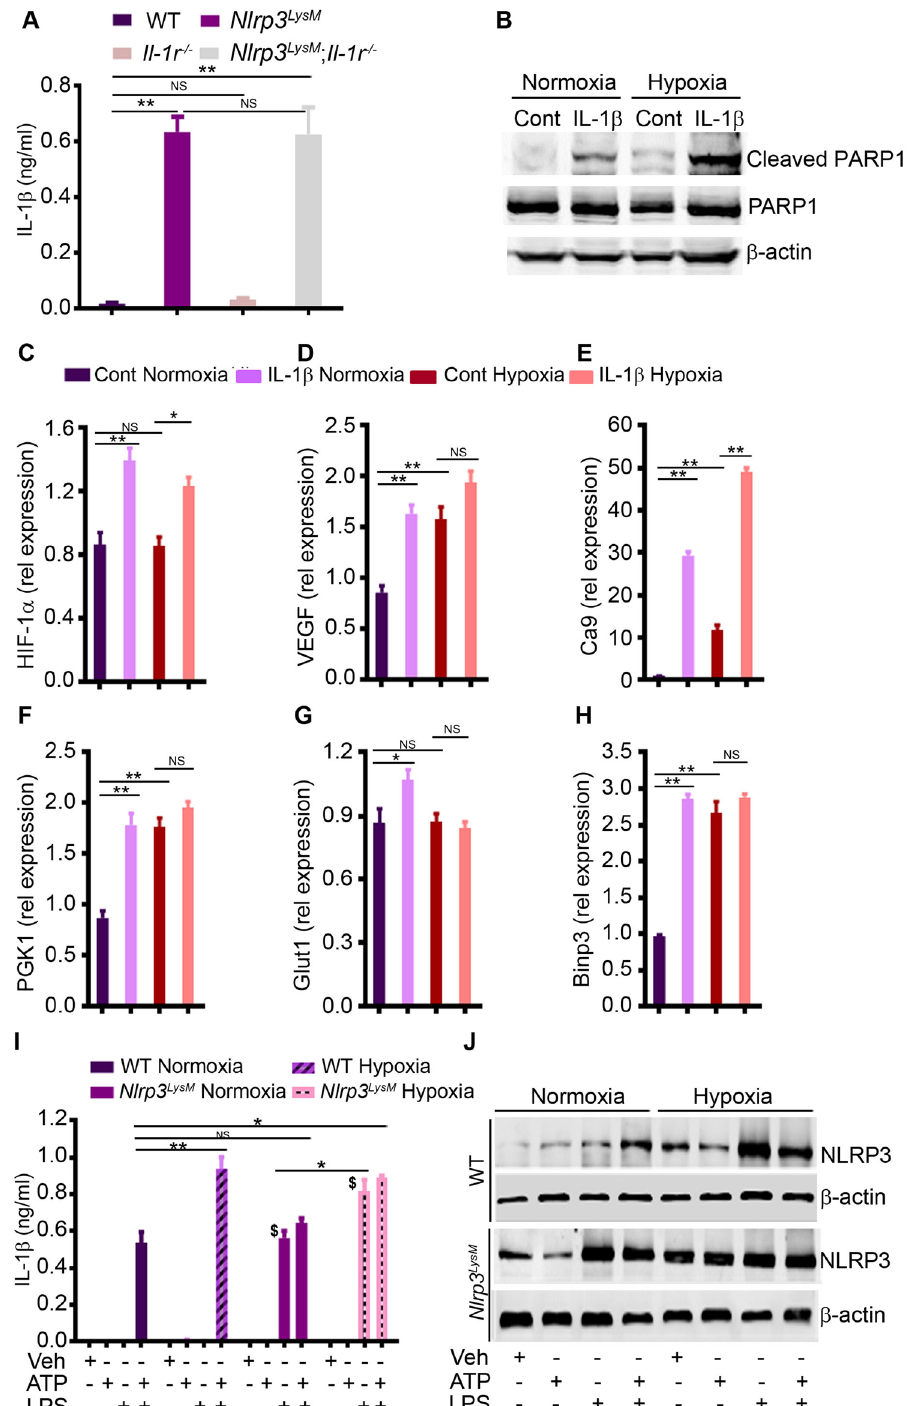
Figure 6. Activation of NLRP3 in myeloid cells causes excessive production of IL-1 β , a cytokine that promotes chondrocyte death. ( A ) Bone marrow cells were centrifuged at 400 × g, and the supernatants were harvested for IL-1 β measurement. ** P < 0.005. ( B ) Western blot analysis of the effects of IL-1 β on PARP1 cleavage in chondrocytes. Cells were treated with IL-1 β for 24 hours. β -actin was used as loading control. Cont, control. qPCR analysis of the expression of HIF-1 α ( C ), VEGF ( D ), Ca9 ( E ), PGK1 ( F ), Glut1 ( G ) and Binp3 ( H ). RNA were isolated from murine chondrocytes from the ribs of 2-day old pups. Data are expressed as the mean ± SEM. * P < 0.05; ** P < 0.005; Cont, control. Rel, relative. NS, not significant. ELISA analysis of IL-1 β levels in conditioned media ( I ) and Western blot analysis of NLRP3 expression ( J ) from BMM treated with 100 ng/ml LPS for 3 hours, then with 5 mM ATP for 30 minutes in normoxic or hypoxic conditions. Data are representative of 2–3 independent experiments and expressed as mean ± SEM. * P < 0.05; ** P < 0.005; $ P < 0.001 vs. WT normoxia +